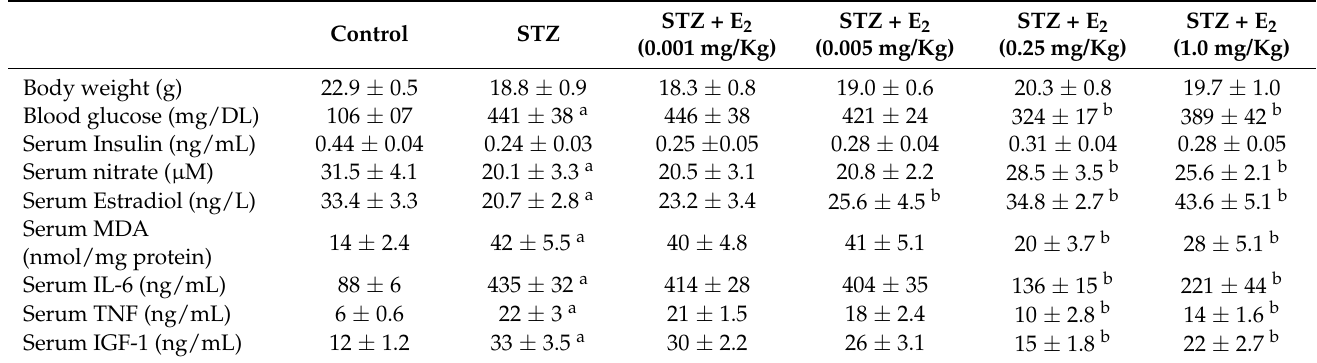
Table 2. Serum biochemical parameters analyzed in female mice at 9